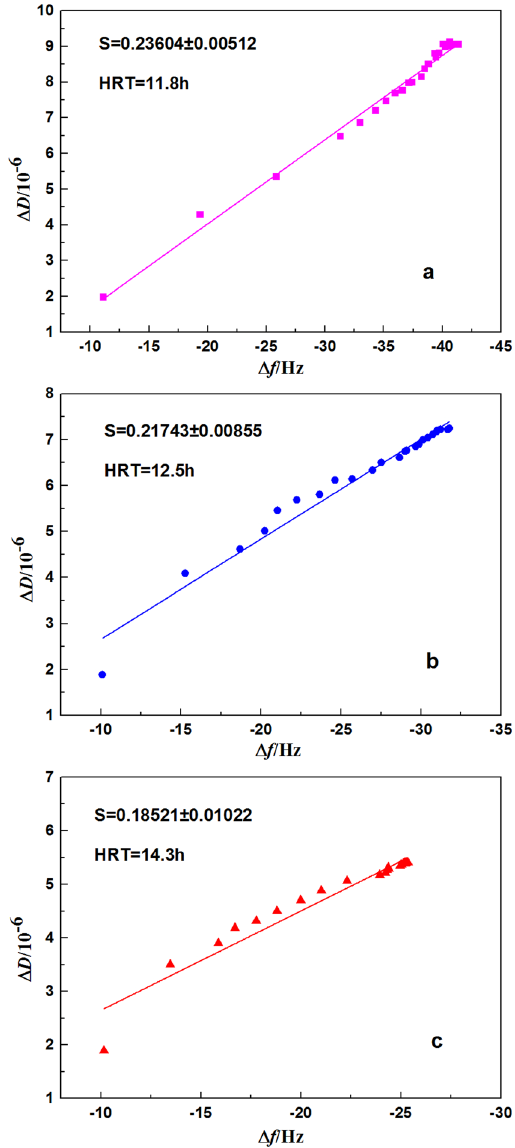
Figure 4. Comparison of the fluidity of different EPS extracted from the reactor after runs operated at different HRTs: ( a ) 11.8 h; ( b ) 12.5 h; and ( c ) 14.3 h. Dissipation factors versus frequency shifts during adsorption are shown. S shows the slope of the linear